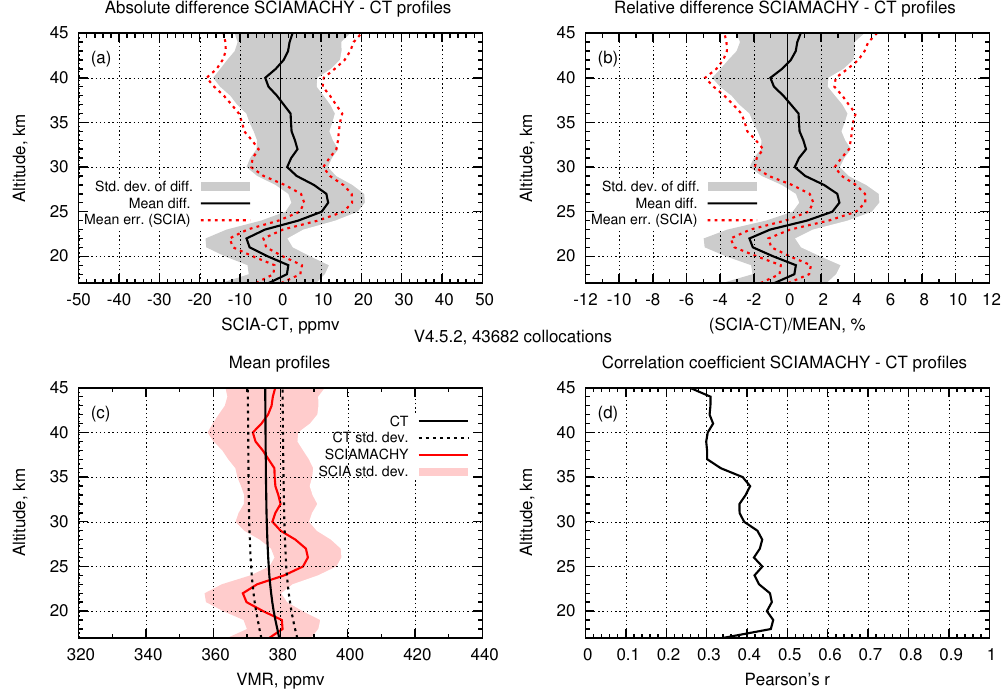
Figure 12. Same as Fig. 8, but for comparison of retrieved SCIAMACHY CO 2 profiles (ONPD V4.5.2, red) with CarbonTracker CT2013 data